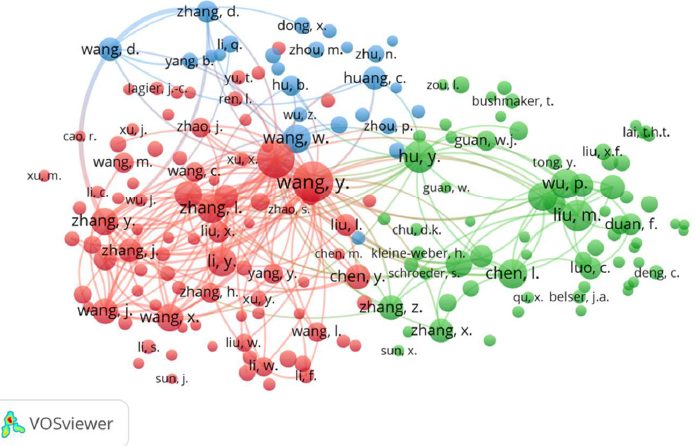
Figure 6. Network visualization map of the journal co-citation analysis for the authors with published documents on COVID-19 and eyes with a minimum of 55 citations. The authors with the same color are often co-cited. The most co-cited authors of the green cluster are specialized in virus transmission and ocular findings related to COVID-19, in the field of ophthalmology. The most co-cited authors of the red cluster work in clinical features, infectious diseases, and radiological findings, mostly in the respiratory medicine field. Blue cluster represents the authors who worked on virus identification using molecular techniques and genetic